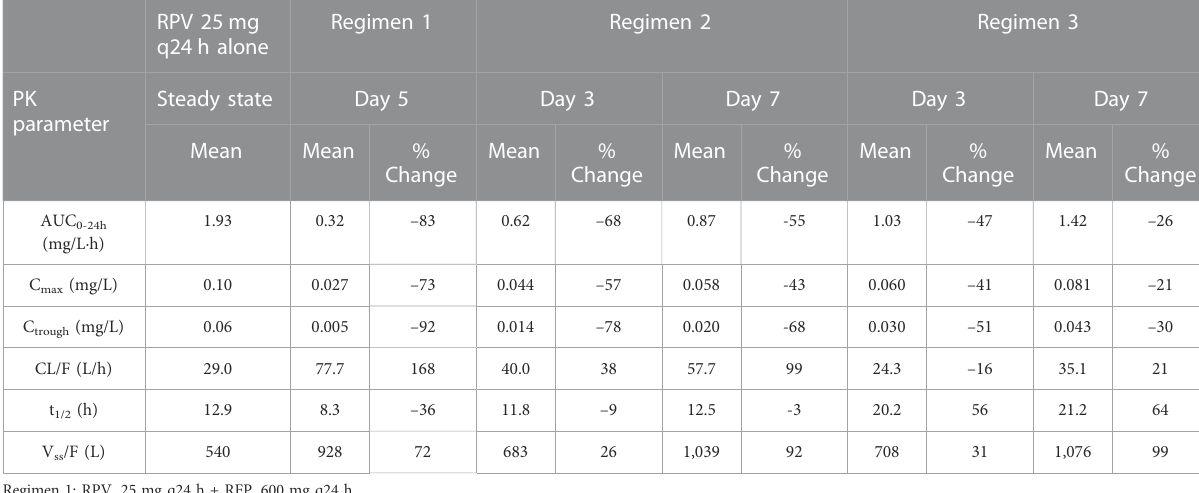
TABLE 2 Predicted PK parameters of orally administered rilpivirine with and without rifapentine in multiple dosing regimens. RPV 25 mg q24 h